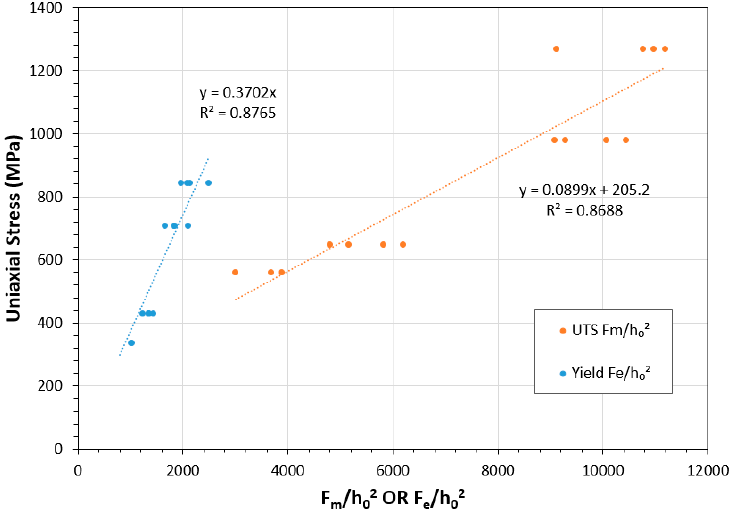
Figure 6. Relationship between Yield Stress vs. F e / h 02 and Ultimate Tensile Strength vs. F m / h 02 for C263 variants where uniaxial properties are known.